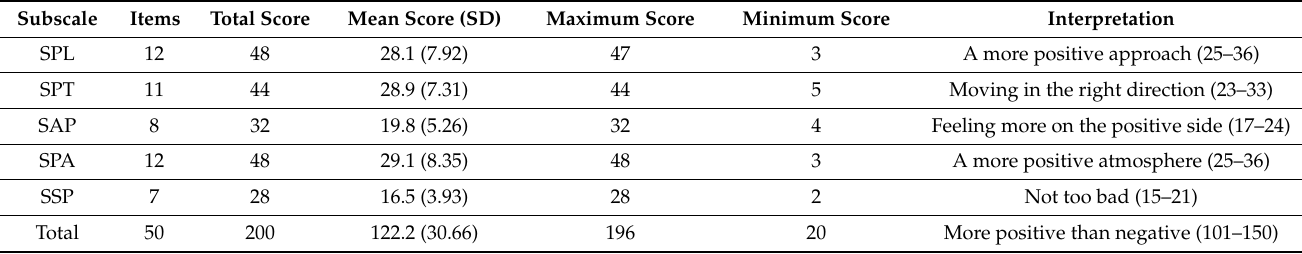
Table 5. Mean score of DREEM tool.